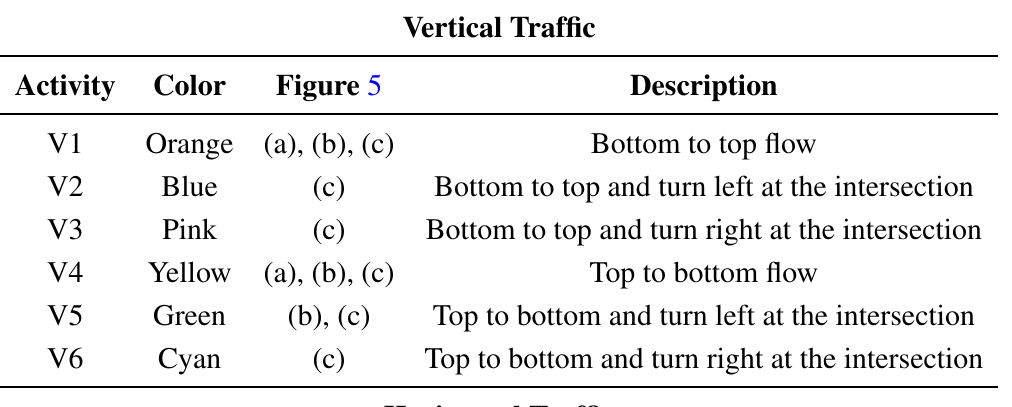
Table 2. Activity descriptions of two main